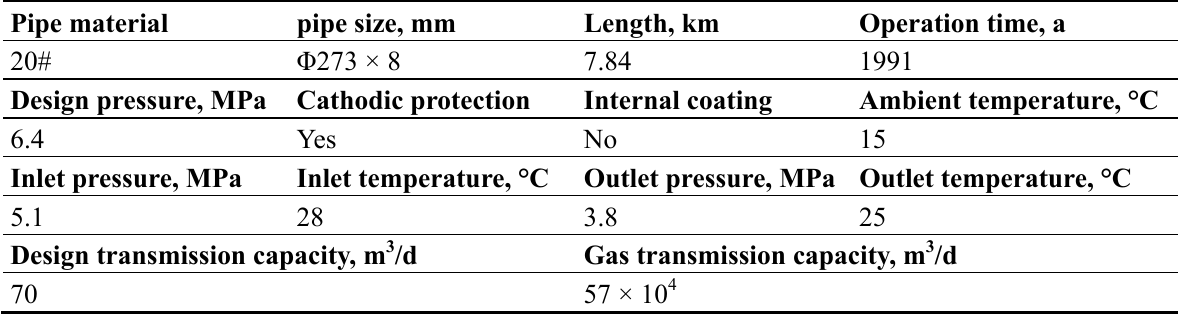
Table 12. The basic data on the validation pipeline.